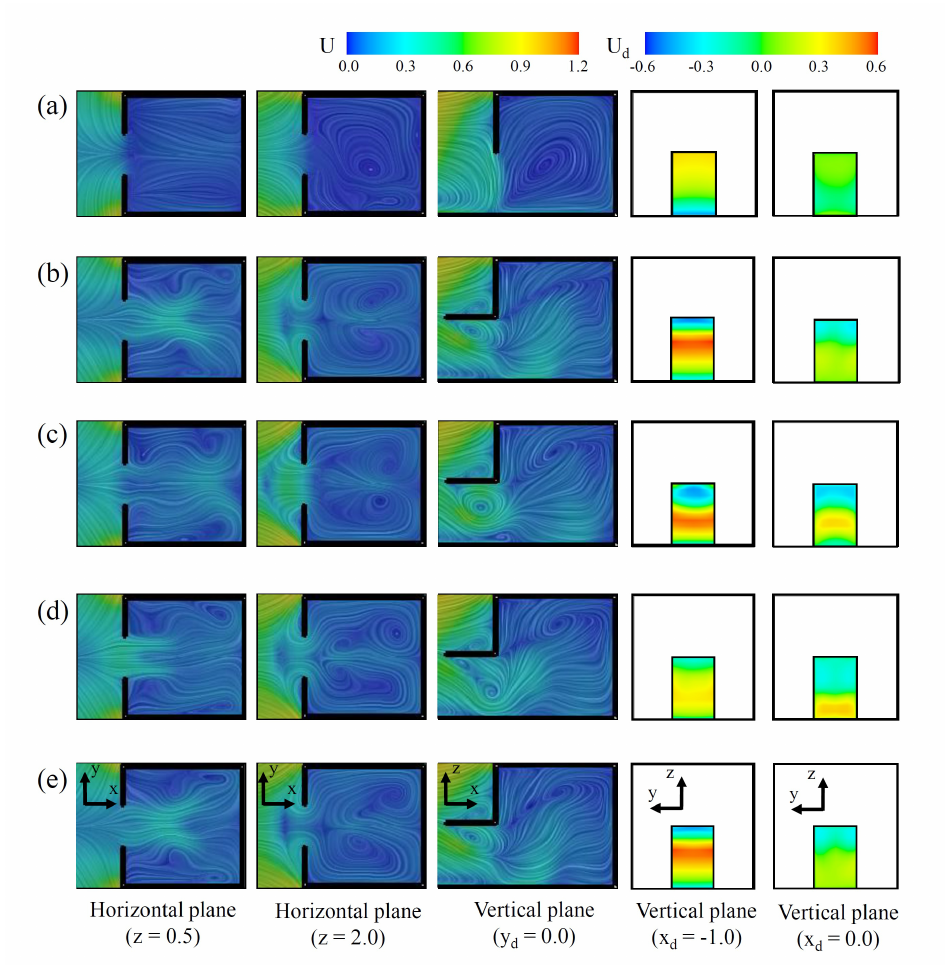
Figure 8. Contour plots of the velocity magnitude along with streamlines and the velocity normal to the entrance for the single-sided windward building: ( a ) time-averaged flow fields for the building without an overhang and ( b – e ) instantaneous flow fields for the building with the overhang ( L / D = 0.8 ) in a quasi-steady state period of 920.0–951.0 s; ( b ) t = 920.0; ( c ) t = 931.3; ( d ) t = 942.5; and ( e ) 951.0